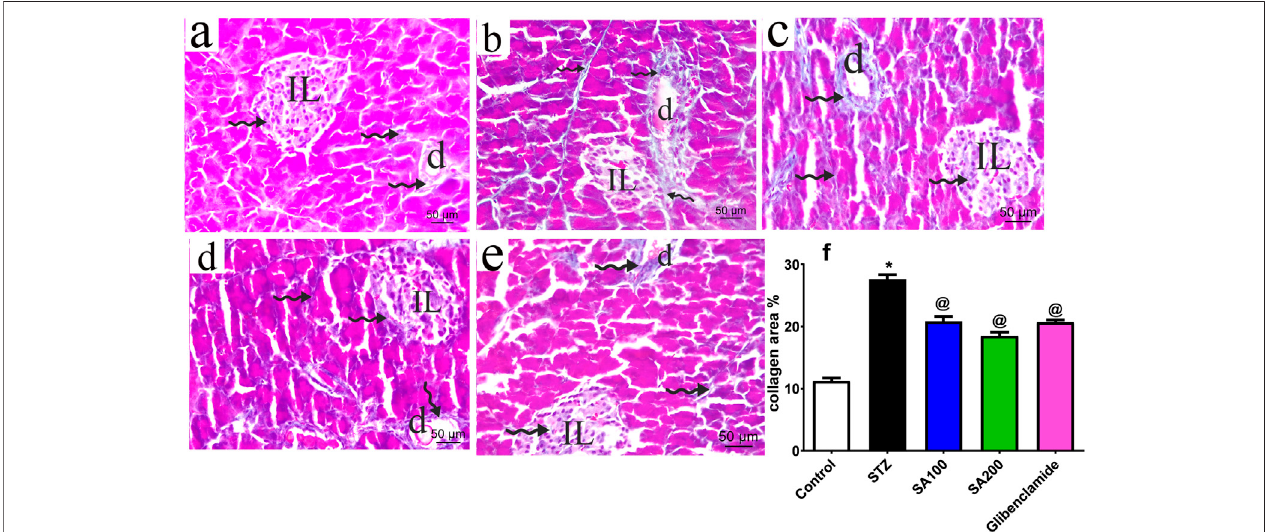
FIGURE 4 | Stained photomicrographs with Mallory trichrome of pancreatic sections presenting collage fi bers distribution from normal rats (A) , STZ diabetic rats (B) , S. aqueum (SA) extract (100 mg/kg) (C) , S. aqueum (SA) extract (200 mg/kg) (D) , the reference drug, glibenclamide (E) , and collagen area percent (%) (F) . Results are presented as mean ± SEM. *Signi fi cant difference related to the normal control group and @ related to STZ diabetic rats at p < 0.05 by One-Way ANOVA and Tukey post hoc test, n (cid:2) 6. Zigzag arrow indicating blue staining of the collagen of (IL) Langerhans islets and (D) duct. Scale bar: 50 μ m.